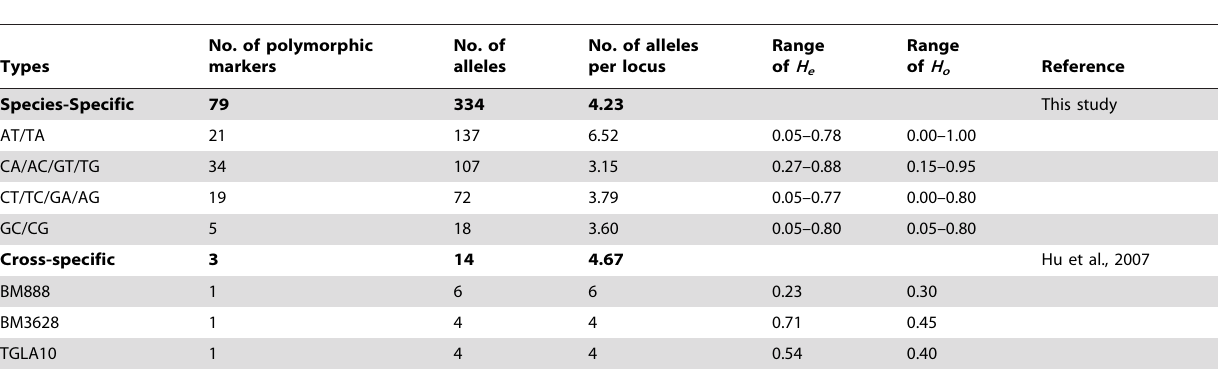
Table 2. Genotyping of newly designed di-nucleotide species-specific microsatellites and cross-species (cattle to water deer) microsatellites on Korean water deer ( n =20